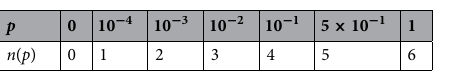
Table 1. Definition of the function n ( p ).